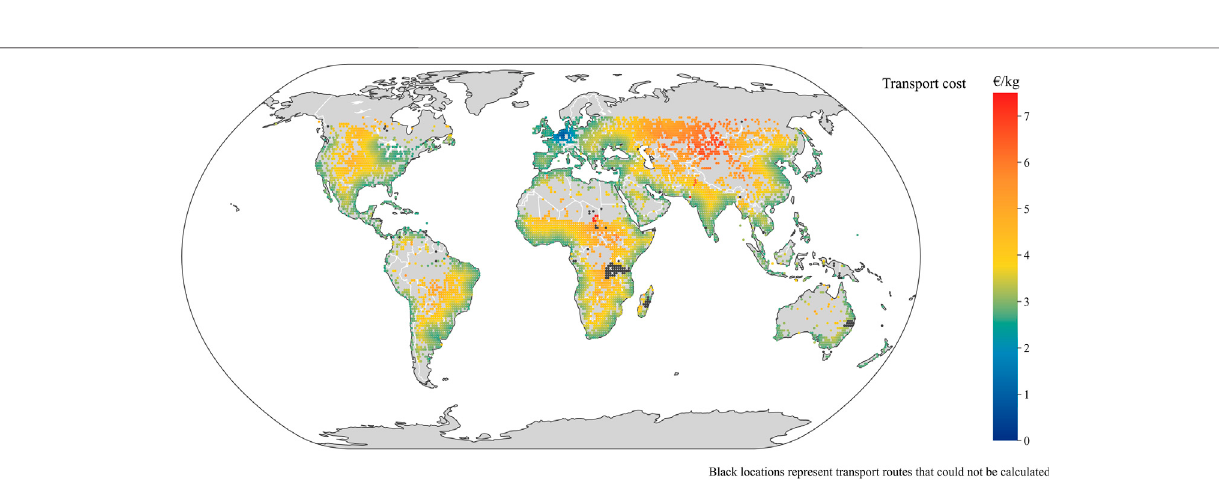
FIGURE 5 | Production cost of H 2 at each of the 5970 studied locations for the baseline scenario (100 kt/y AE electrolyser in 2030, centralised reconversion). Results are from a Monte Carlo simulation with 1,000 iterations.